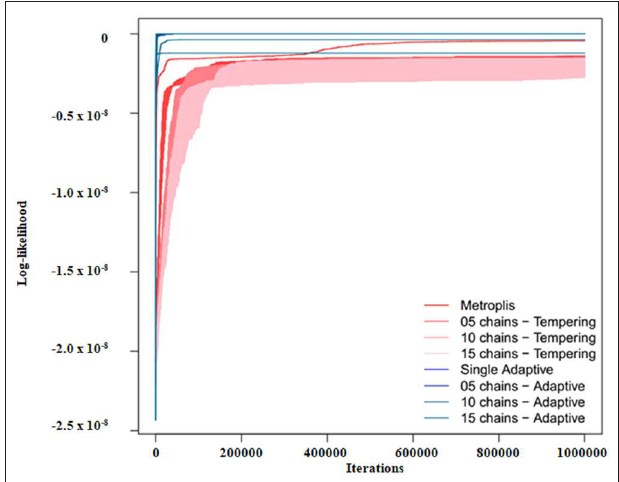
FIGURE 3 | Example of the log-likelihood trace for model 1 and noise variance 1%.